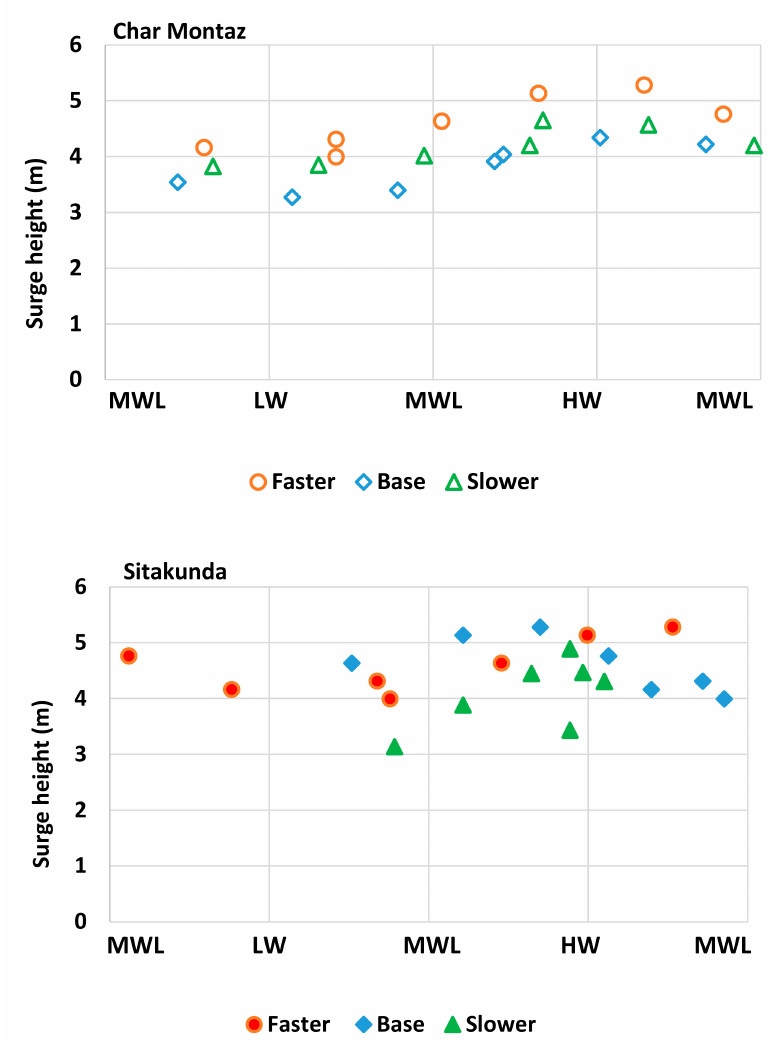
Figure 6. Maximum surge height (m) at different tidal phases for three track speed cases during Cyclone Sidr at Char Montaz ( upper panel ) and at Sitakunda ( lower panel